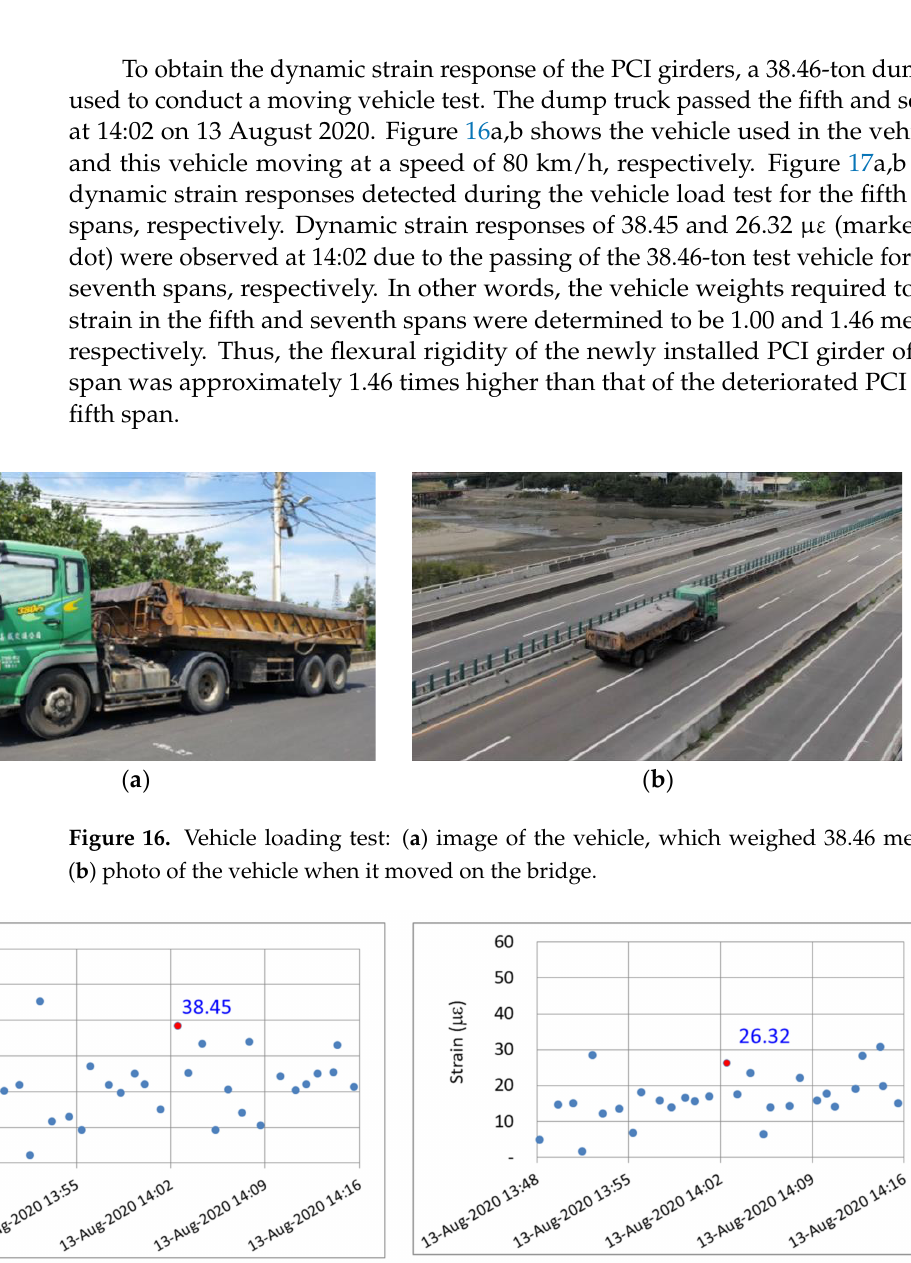
Figure 15. Dynamic strain monitoring device: ( a ) on-site installation; ( b ) solar charging panels with rechargeable batteries.